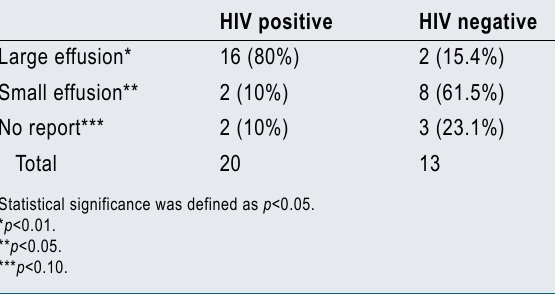
TABLE III. PERICARDIAL EFFUSION